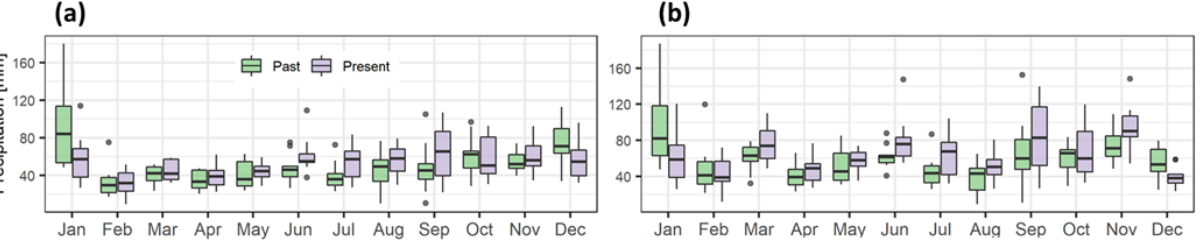
Figure 3. Monthly mean precipitation averaged over the two periods, i.e., past (1965–1975) and present (2008–2018). (a) AGRB. (b) PGRB.